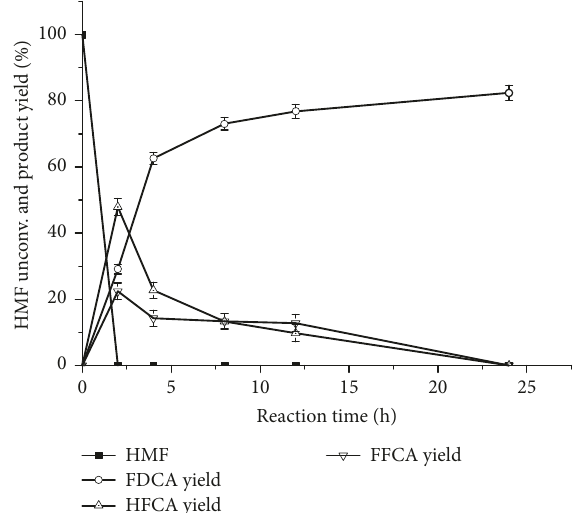
Figure 7: Effect of the reaction time on the HMF